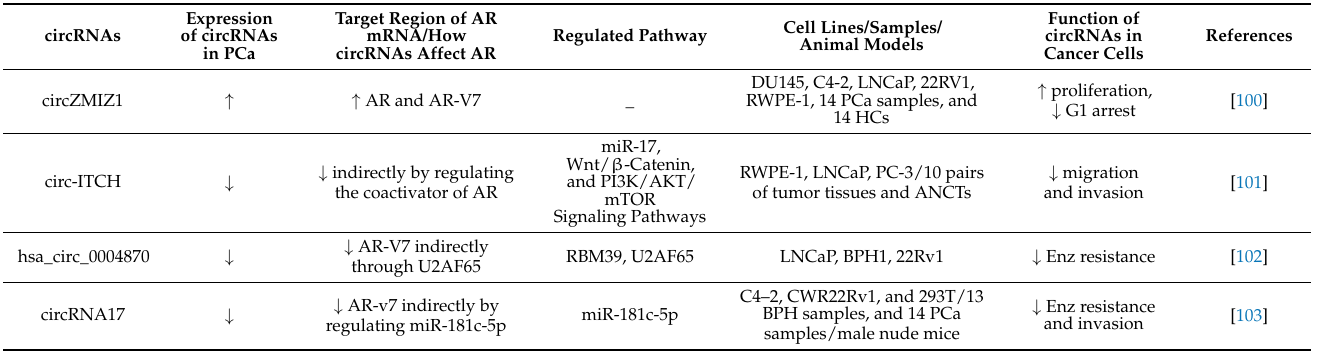
Table 5. The effects of different circRNAs on AR in prostate cancer (HCs: healthy controls, Enz: enzalutamide, ↓ : decrease in, ↑ : increase